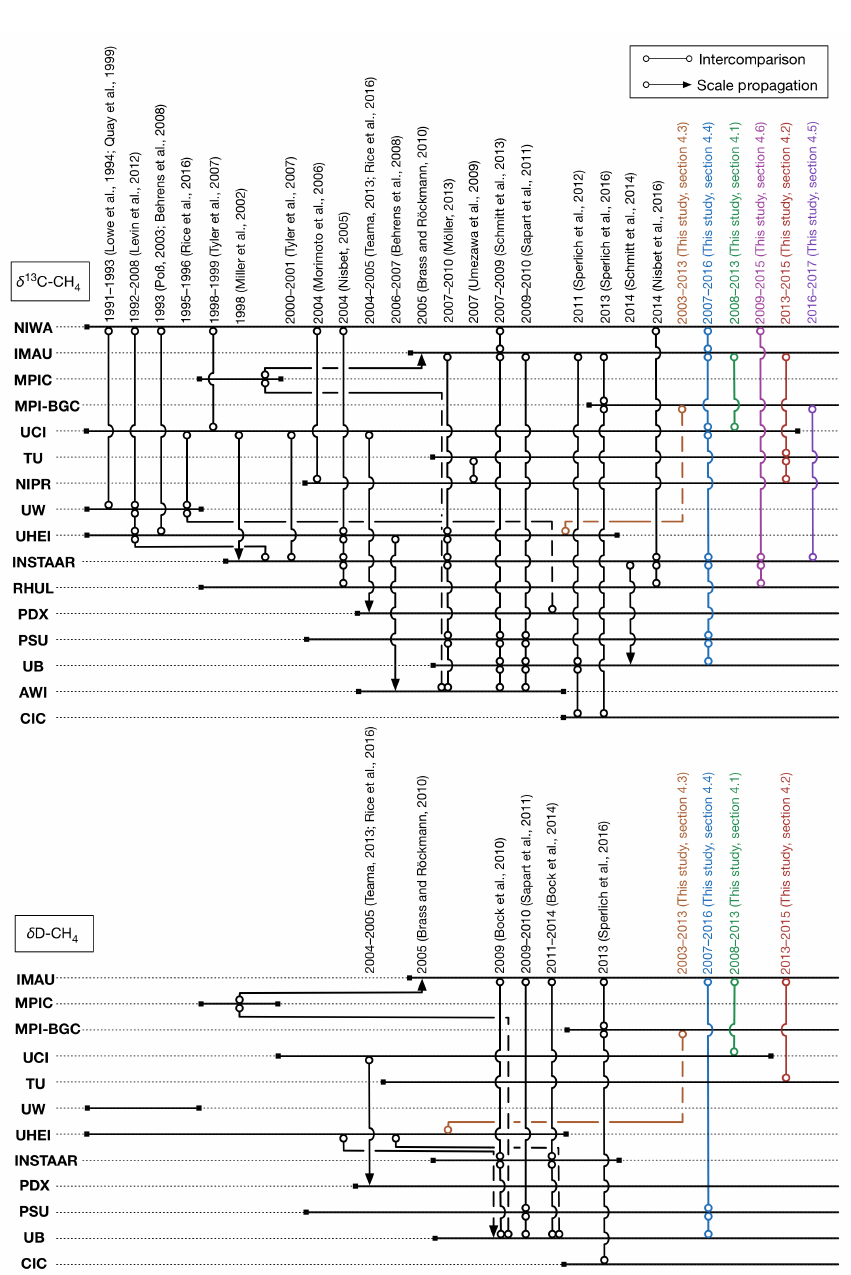
Figure 1. A schematic overview of the previous and present intercomparisons among laboratories for δ 13 C-CH 4 (top) and δ D-CH 4 (bottom). Intercomparisons are marked by lines with open circles at both ends, and scale propagations are marked by lines with an arrow at one